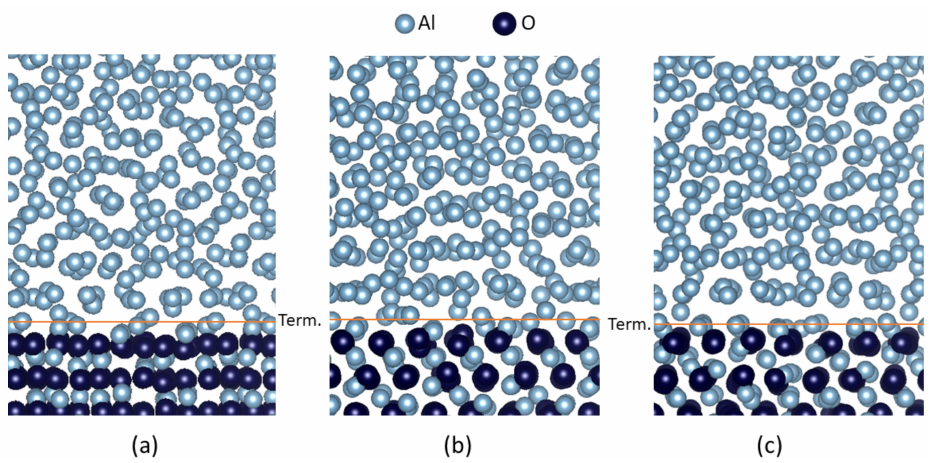
Figure 3. An Al layer terminates the oxide substrates in the liquid. Snapshots of the equilibrated Al( l )/ α -Al 2 O 3 {0 0 0 1} ( a ), Al( l )/ γ -Al 2 O 3 {1 1 1} Al_1 ( b ) and Al( l )/ γ -Al 2 O 3 {1 1 1} Al_2 ( c ) systems [49,62]. The terminating Al layers are marked by the orange lines.